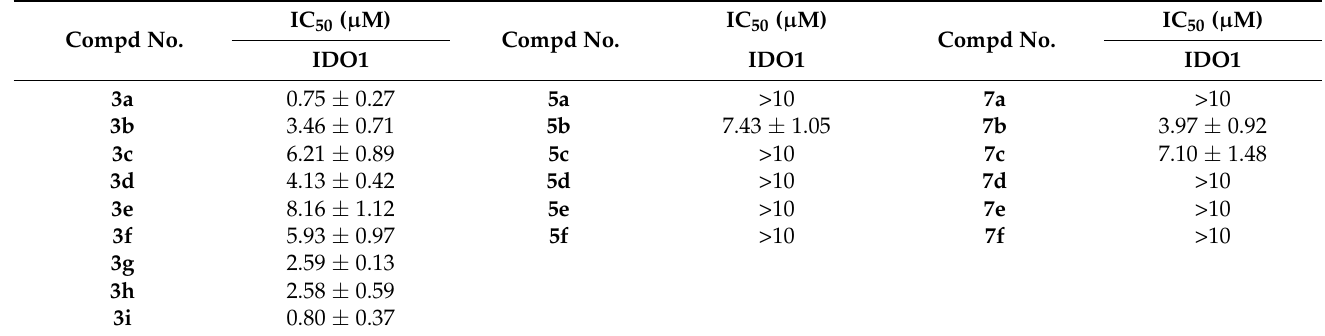
Table 2. IDO1 inhibitory activities of designed